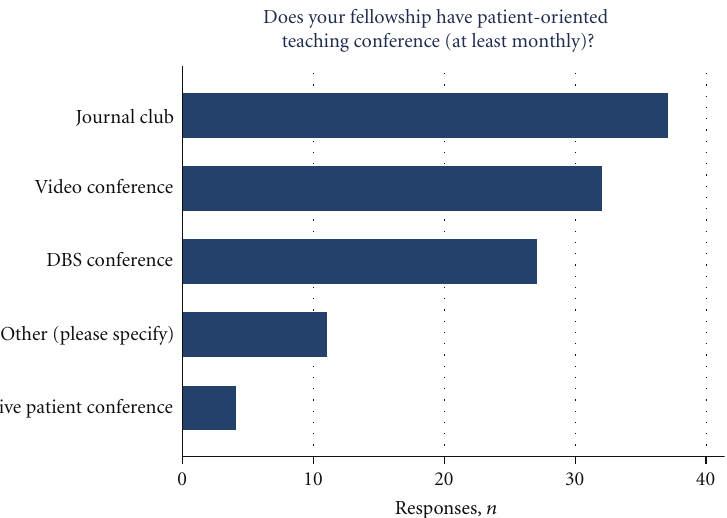
Figure 3: Number of programs that hold regular patient oriented teaching conferences.